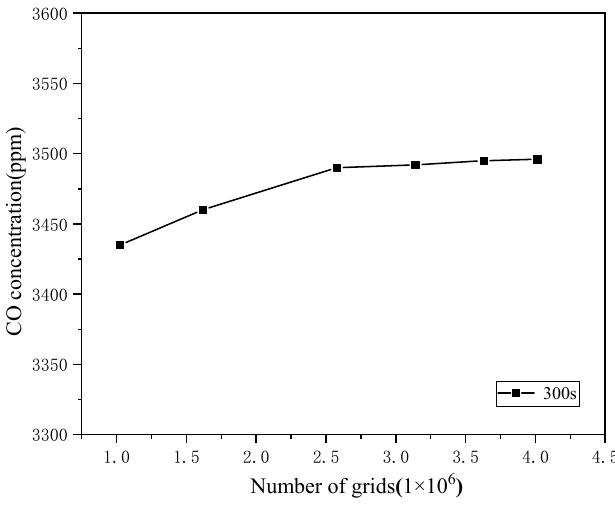
Figure 7. Grid independence test.